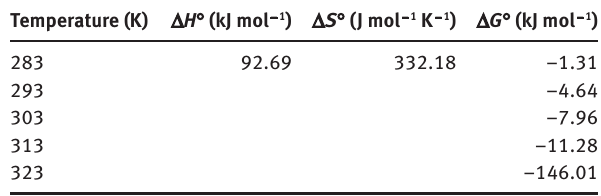
Table 5: Thermodynamic parameters of DBT catalytic